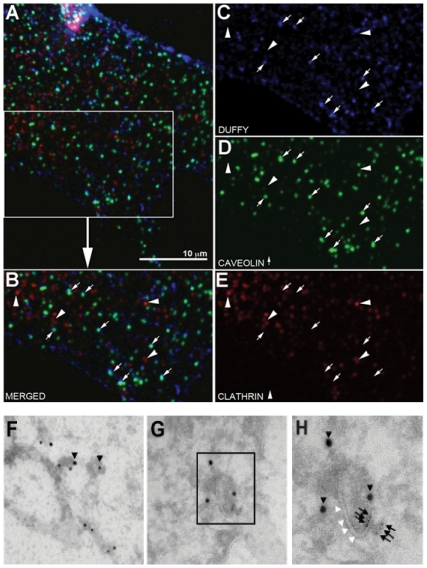
Duffy antigen co-localizes with caveolin-1 but not with clathrin.The DIH cells were stimulated with or without CCL2 100 ng/ml for 120 minutes. Figure A shows a typical single plane confocal optical section from the lamellipodial region of a cell, with Panel B focusing at a specific area on the cell outlined by the rectangle in A. Panel B is then separated into specific color signals to accentuate the localization status of each protein. Cells are stained for Duffy (Panel C, blue), caveolin (Panel D, green) and clathrin (Panel E, red). Some Duffy positive foci colocalize with the caveolin signal (arrows) while no Duffy signal is seen colocalized with the red clathrin signal(arrowheads). Figure (F-H), by immuno-EM, caveolin-1 was labeled with 10 nm gold particle- (▾), Duffy antigen was labeled with 5 nm gold particle- (↓), colocalization between caveolin and Duffy is observed in flask-like membrane structures- (Δ).